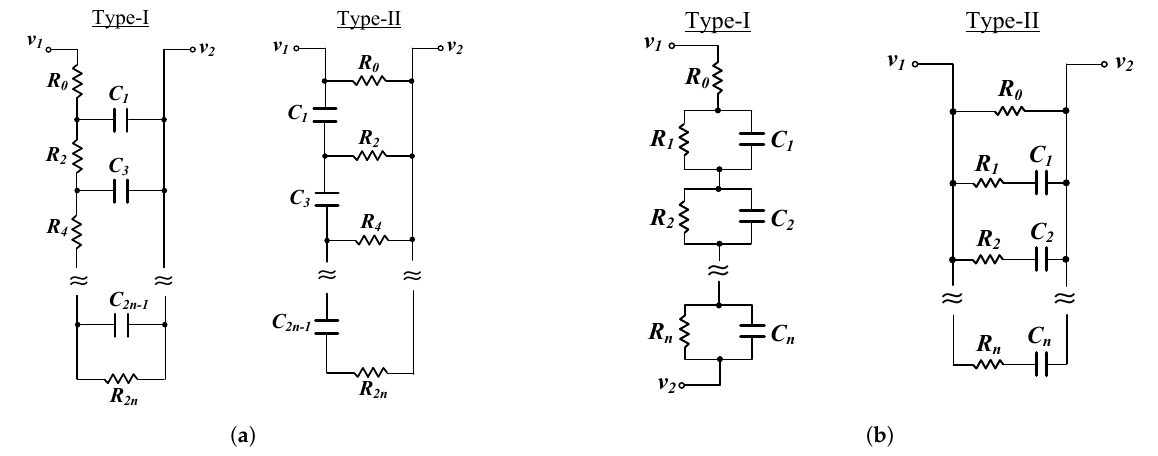
Figure 3. Configurations of ( a ) Cauer and ( b ) Foster RC